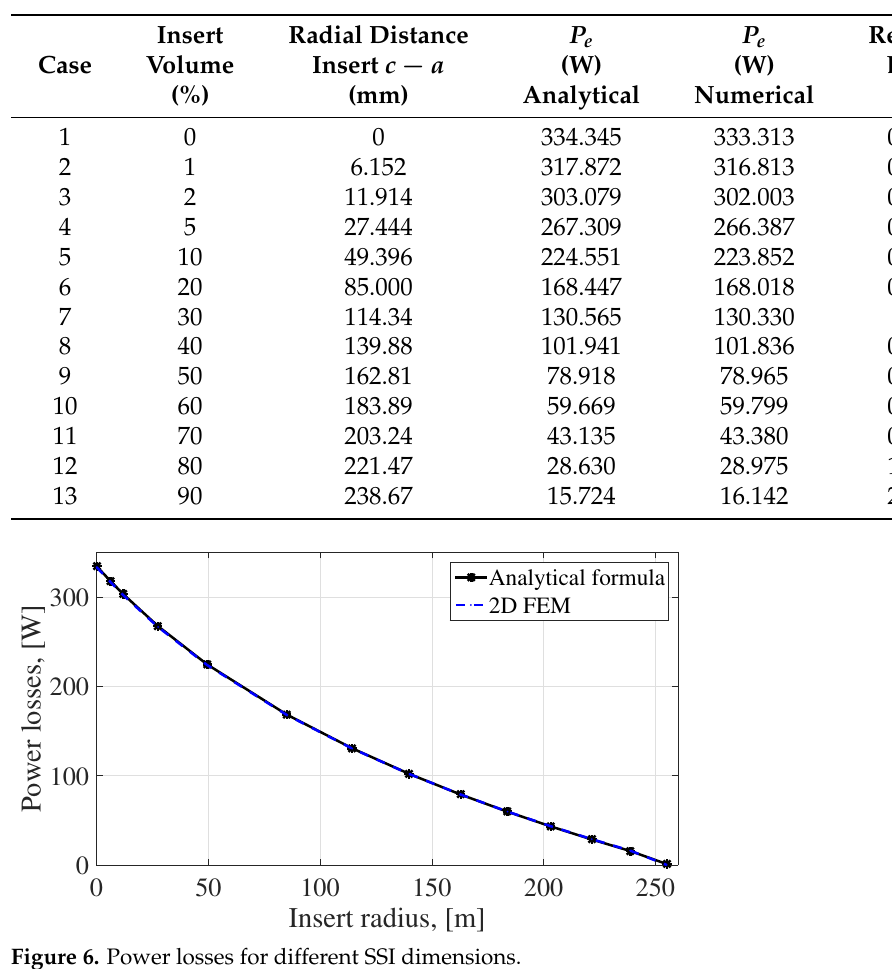
Table 2. Eddy current losses in the tank wall.